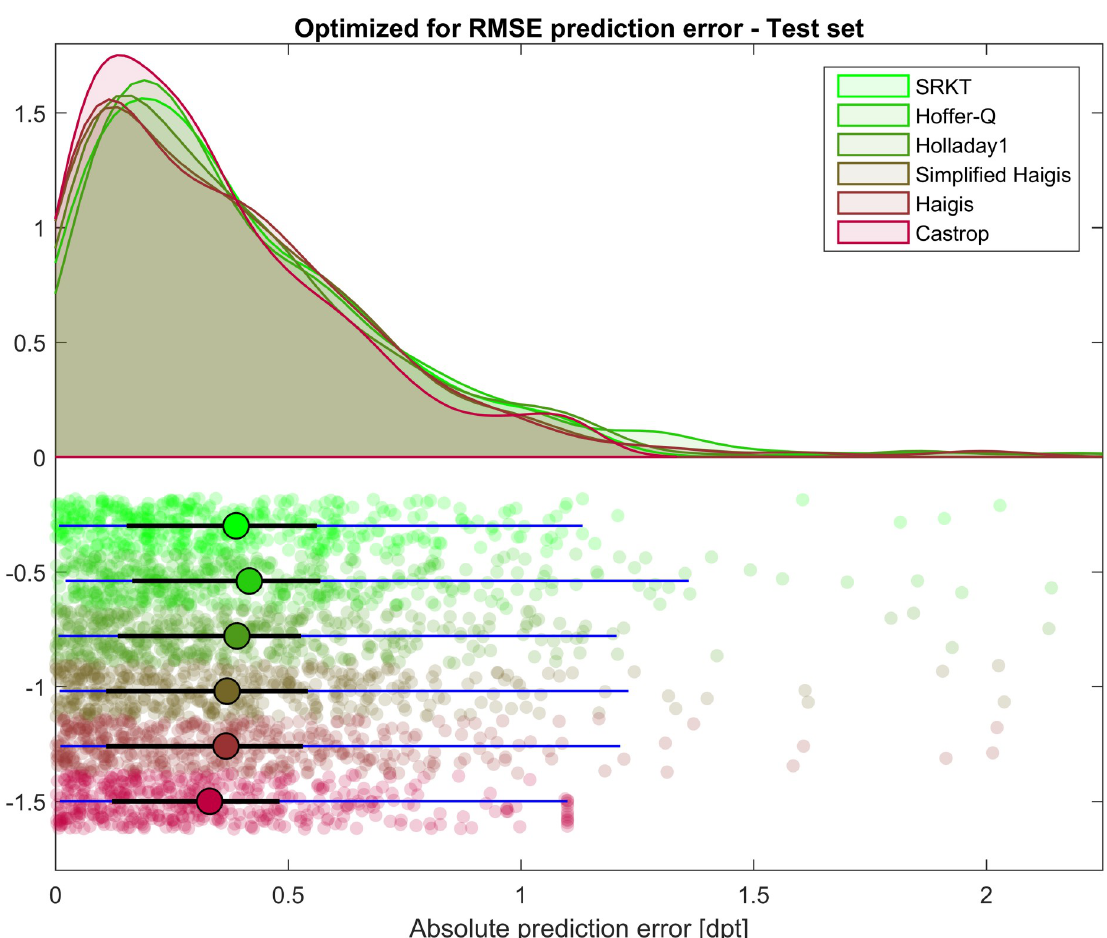
Fig 2. Absolute value of the prediction error absPE as the deviation of achieved spherical equivalent from the formula predicted refraction. Formula constants have been optimized on the training dataset (N = 1017) and cross-validated on the test set (N = 435). The upper part of the plot shows the approximated kernel density distribution for the 6 formulae under test, and the lower part the scatter of the absPE together with the median (circle), the quartiles (black line), and the 90% confidence interval (5% and 95% quantile, blue line). The blue lines in the lower plot representing the 90% confidence interval show that the absPE is largest with the Hoffer-Q formula and lowest with the Castrop and the SRKT formula.